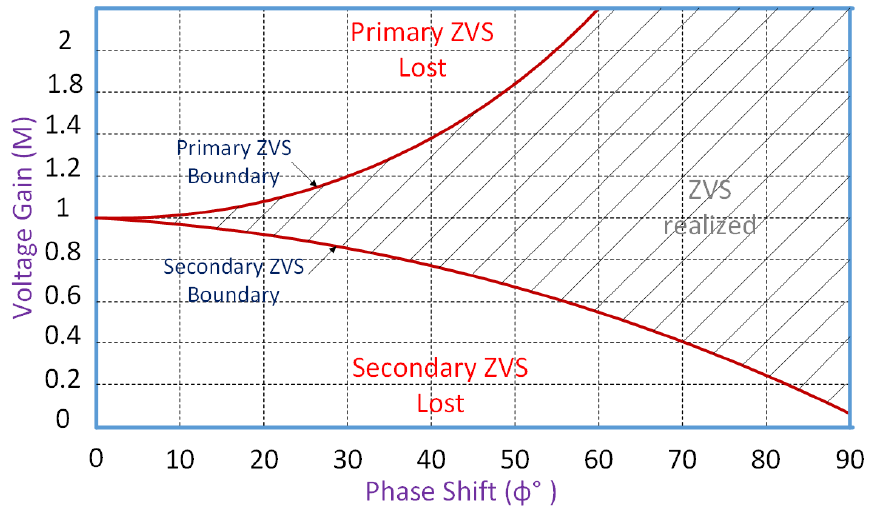
Figure 11. Soft-switching region of a DAB converter using SPS